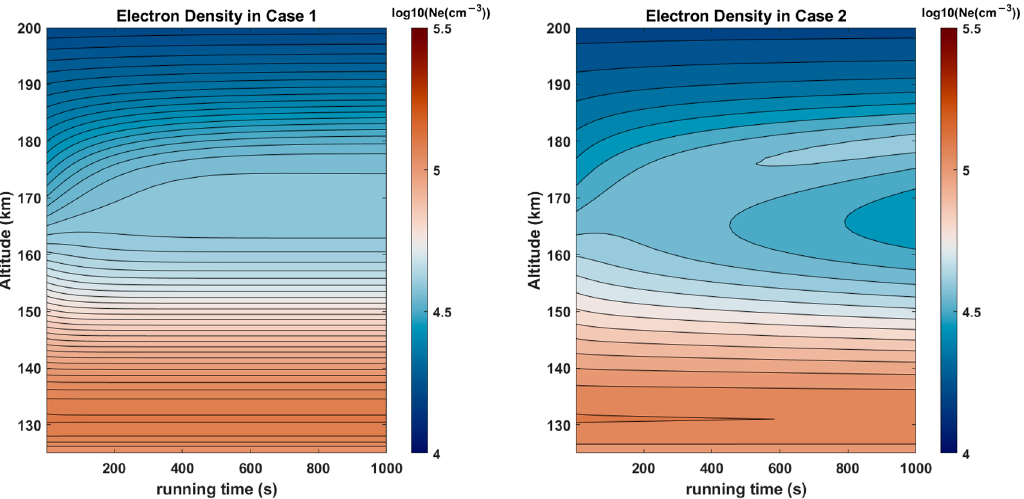
Figure 7. Temporal variations in electron density profiles at running times in Cases 1 and 2.